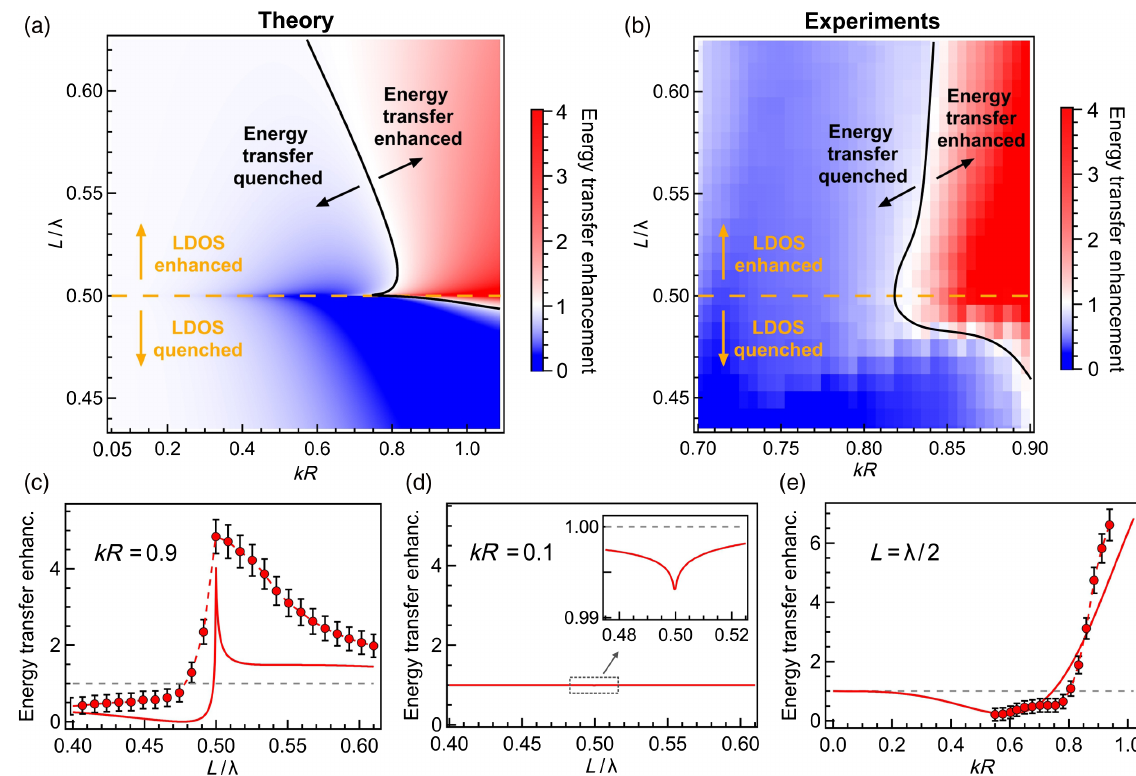
FIG. 4. Two-dimensional maps summarizing the dipole-dipole energy-transfer enhancement F as functions of the normalized cavity ET length L= λ and dipole-dipole separation kR . (a) Simulated map and (b) experimental map for the dipoles in parallel orientation [as in Fig. 3(a)]. The donor dipole is fixed at 11.2 cm from the nearest mirror. In (a) and (b) the black lines show the contour where the energy- transfer enhancement equals unity. The yellow dashed lines show the boundary between LDOS enhancement and quenching at L= λ ¼ 0 . 5 . The theoretical and experimental maps share the same color scale. (c) Energy-transfer enhancement factor obtained for kR ¼ 0 . 9 as a function of the normalized cavity length L= λ . The solid dashed line represents the numerical prediction while the dots are 1 . (d) Same as (c) for kR ¼ 0 . 1 . The inset is a close-up view of experimental data. The gray dashed line indicates the level where F ET ¼ the region enclosed in the dashed rectangle. (e) Energy-transfer enhancement factor at the cavity resonant length L ¼ λ = 2 for increasing dipole-dipole separation kR . In (c) and (e) the experimental error bars are estimated by summing a 5% experimental measurement error plus a 0.2 fixed contribution to represent the error in estimating the reference level in free